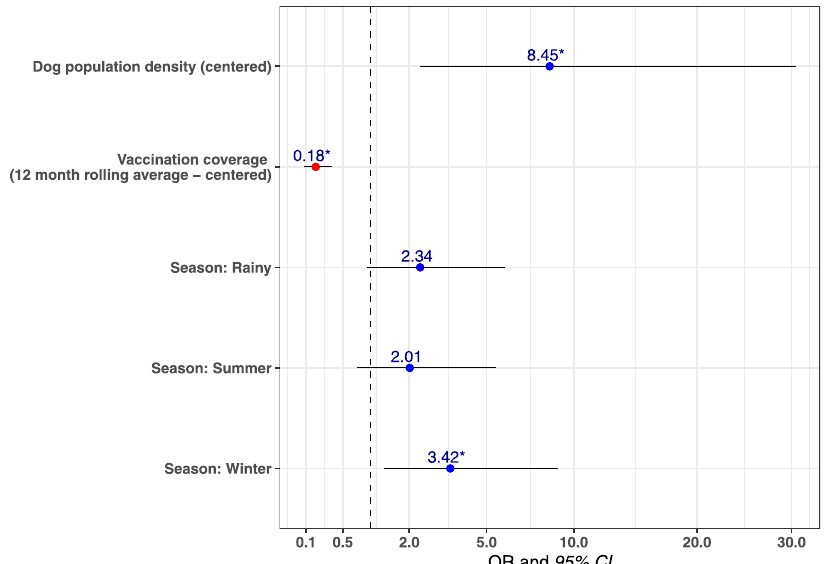
Fig. 4 Multivariable mixed-effects logistic regression model for detecting at least one rabies case by taluka in a month. Multivariable mixed-effects logistic regression model predicting a taluka having at least one con fi rmed dog rabies case in a particular month ( n = 624). Figure shows the Odds Ratio (points) and 95% con fi dence intervals (horizontal lines). Asterisks indicate a p value < 0.05. The model shows that the odds of a taluka having at least one positive dog rabies case in a particular month increased as roaming dog population density increased. Similarly, as the rolling mean 12-month vaccination coverage increased, the odds of a positive rabies case were reduced. The odds of identifying at least one rabies case during the monsoon season (the reference season in the model) were lower, especially compared to the winter season, which had signi fi cantly higher odds. The AUC was calculated as 0.73, indicating that the model was very good at predicting the